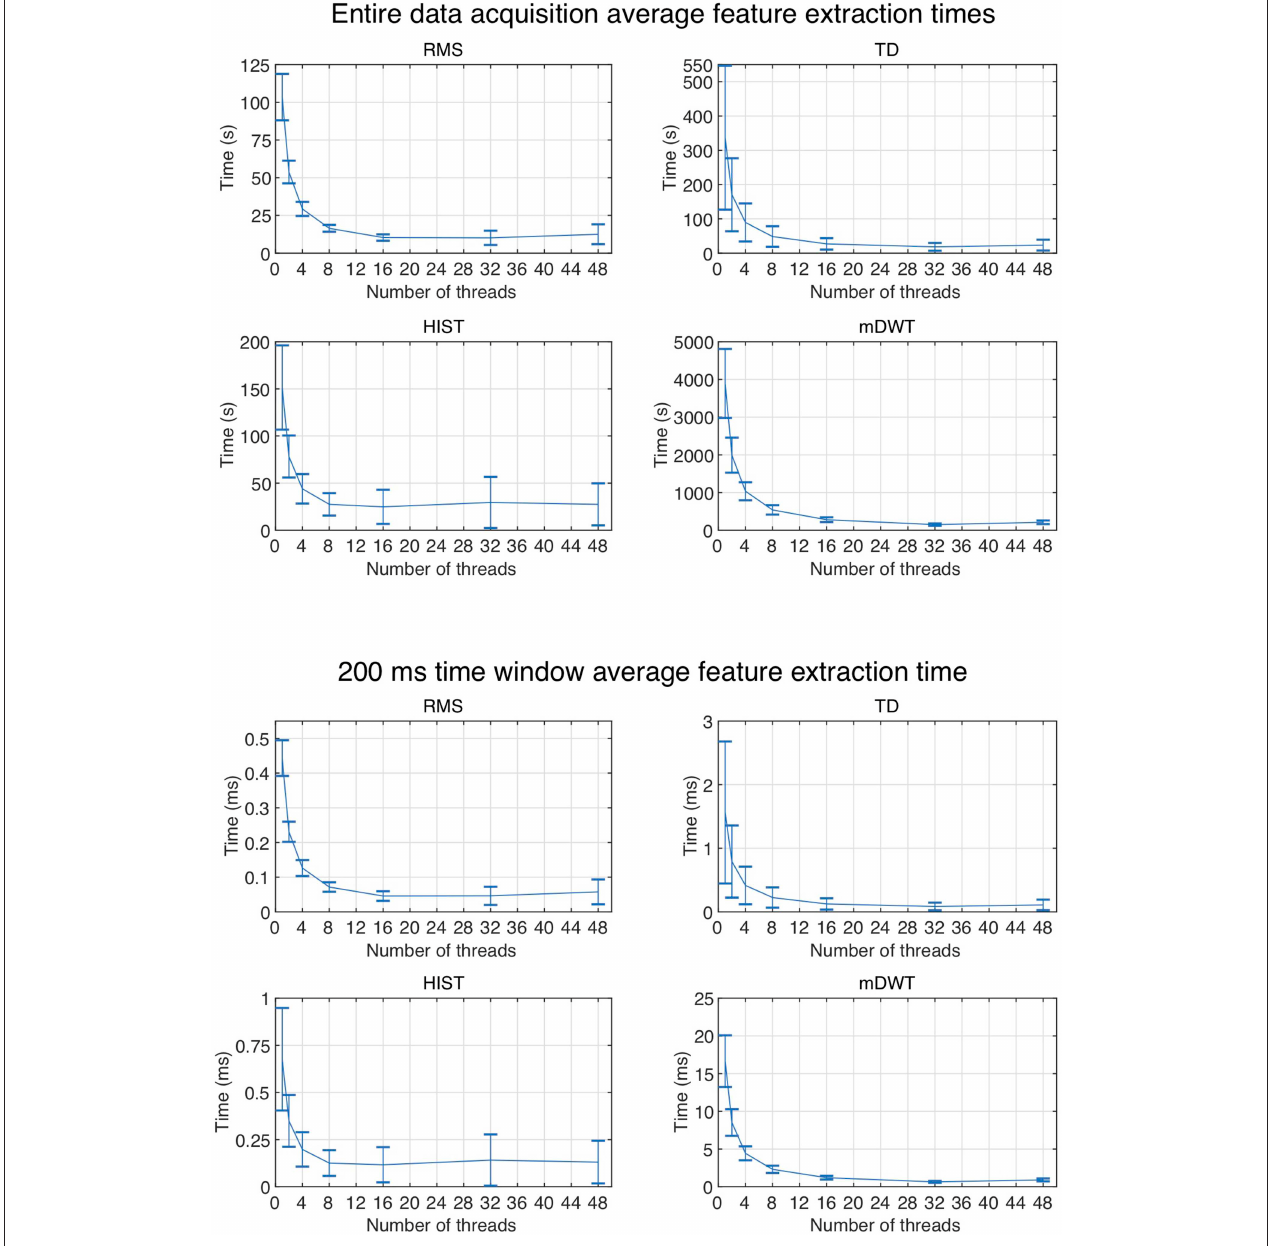
FIGURE 2 | Average subject and time window feature extraction time for all the considered datasets, each signal feature and each test using multiple